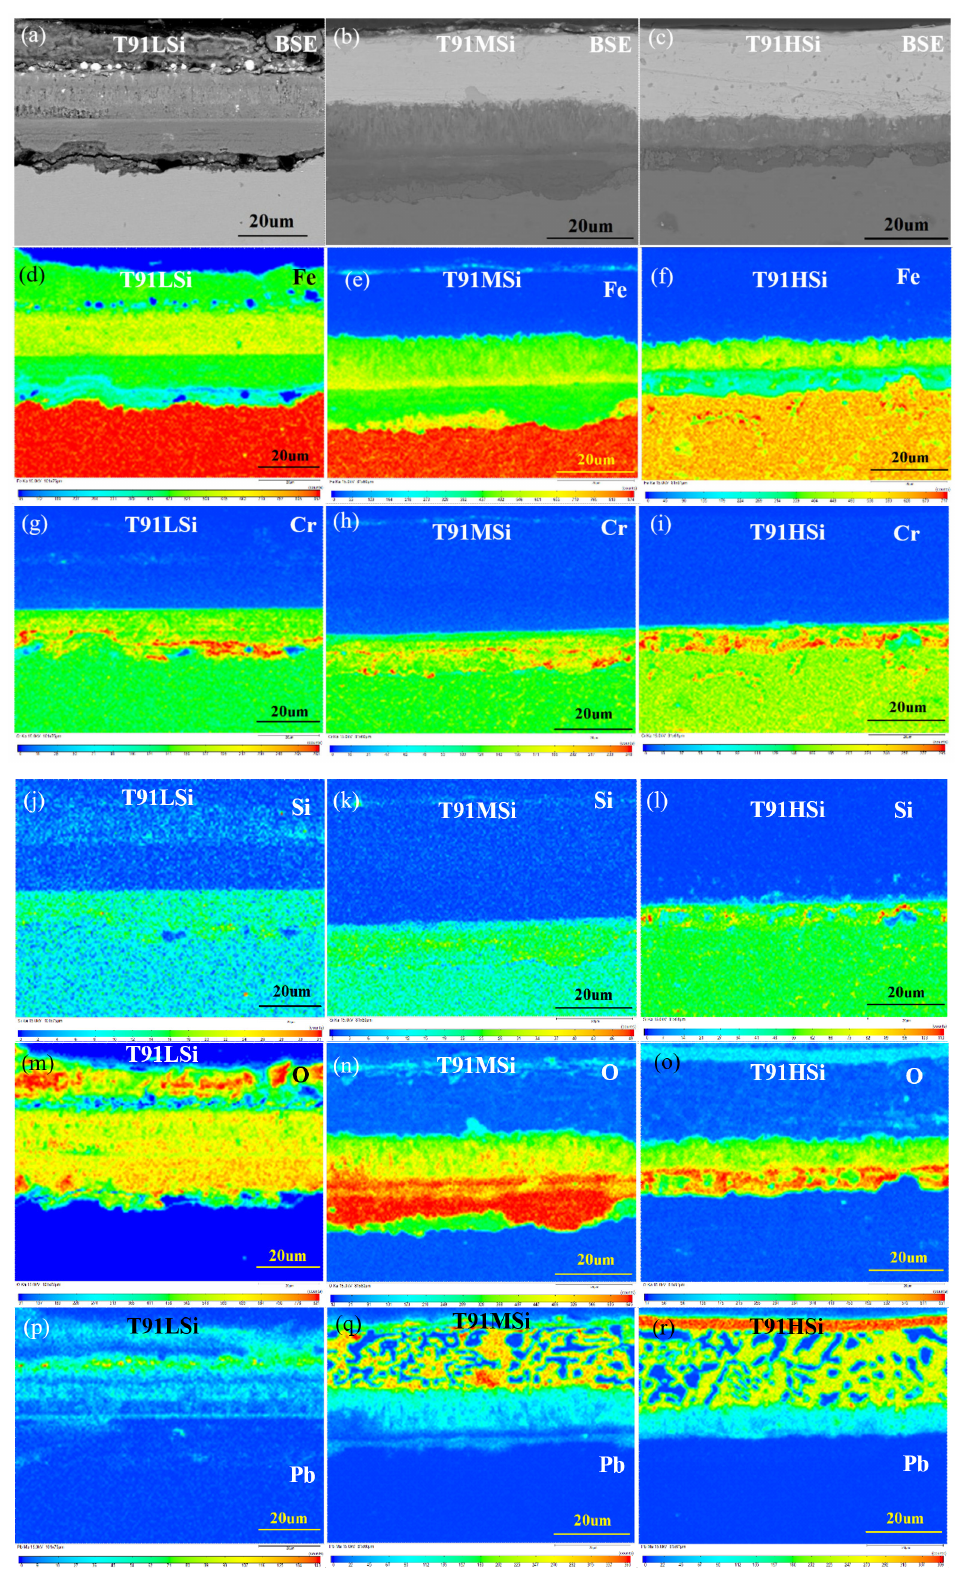
Figure 5. EPMA images of the oxide films for the three steels. ( a , d , g , j , m , p ) for T91LSi, ( b , e , h , k , n , q ) for T91MSi and ( c , f , e , l , o , r ) for T91HSi. ( a – c ) BSE photos. ( d – f ) Distribution of Fe elements. ( g – i ) Distribution of Cr element. ( j – l ) Distribution of Si element. ( m – o ) Distribution of O element. ( p – r ) Distribution of Pb elements. The color from cold to warm indicates a component content from low to high.